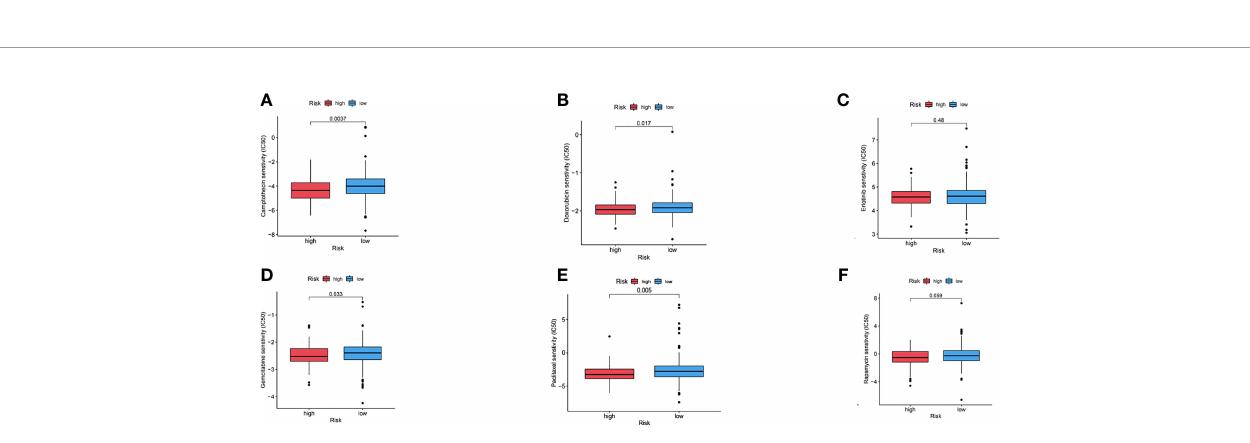
FIGURE 8 | (A – F) Chemosensitivity between different risk groups (Camptothecin, Doxorubicin, Erlotinib, Gemcitabine, Paclitaxel,